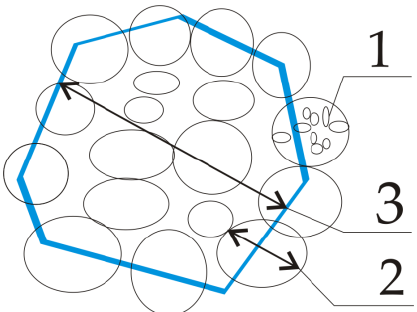
Figure 3: The general scheme of the resulting facet structure.